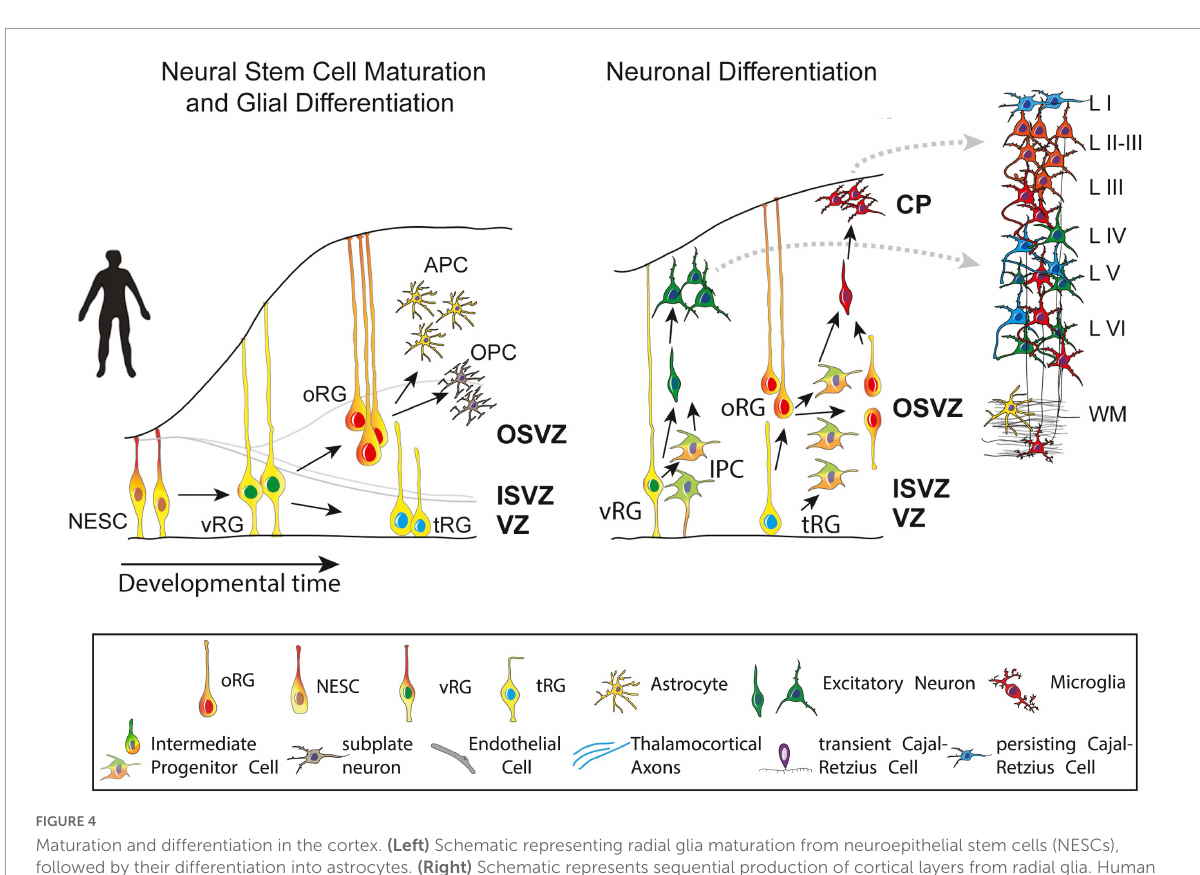
FIGURE4 Maturation and differentiation in the cortex. (Left) Schematic representing radial glia maturation from neuroepithelial stem cells (NESCs), followed by their differentiation into astrocytes. (Right) Schematic represents sequential production of cortical layers from radial glia. Human cortical development involves an expanded diversity of radial glia with distinct maturation trajectories (left) . Neurogenesis in the human cortex occurs in the ventricular zone early in development and progressively shifts toward the outer subventricular zone (OSVZ). The development of the OSVZ is not homogeneous across prospective cortical areas in human fetuses, but increases from prospective mesocortical to prospective isocortical areas (Barbas and García-Cabezas, 2016). IPCs, intermediate progenitor cells; ISVZ, inner subventricular zone; LI–VI, cortical layer I–VI; NESCs, neuroepithelial stem cells; oRG, outer radial glia; OSVZ, outer subventricular zone; SVZ, subventricular zone; tRG, truncated radial glia; vRG, ventricular radial glia; VZ, ventricular zone; WM, white matter. Figure adapted from Cadwell et al. (2019).